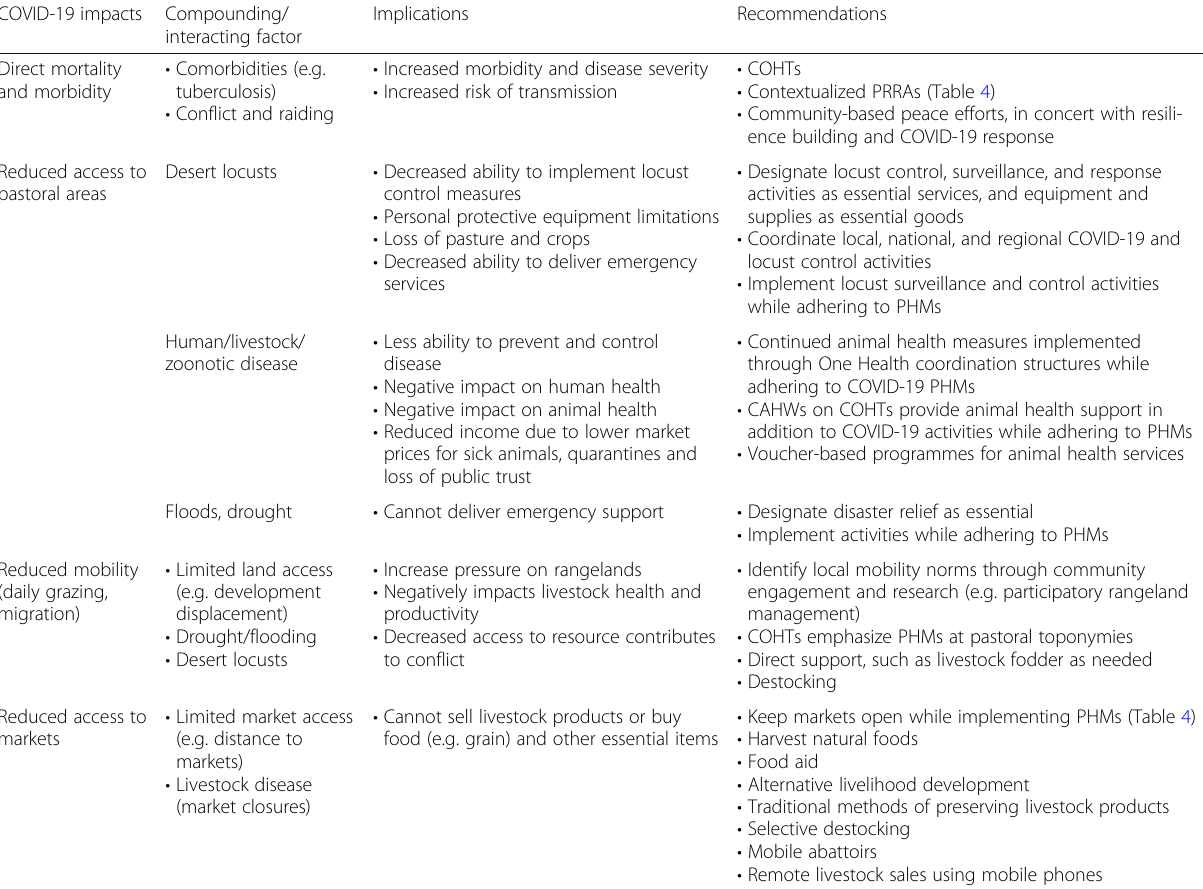
Table 5 Recommendations for how to combat the combined impact of COVID-19 and ongoing shocks and stressors COVID-19 impacts Compounding/ interacting